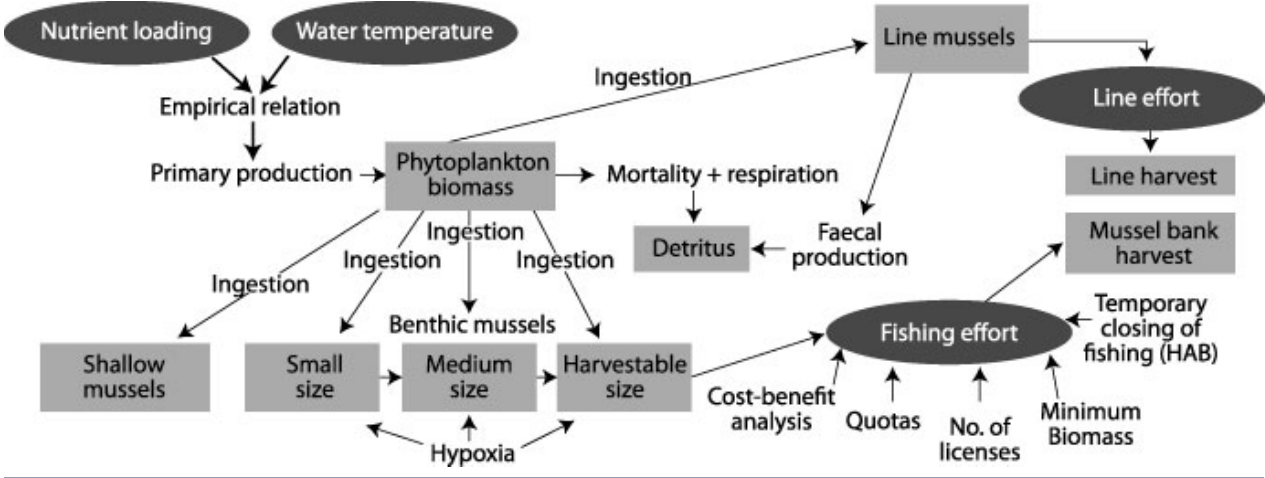
Fig. 4. Conceptual flow diagram of the ecological-social-economic (ESE) model.